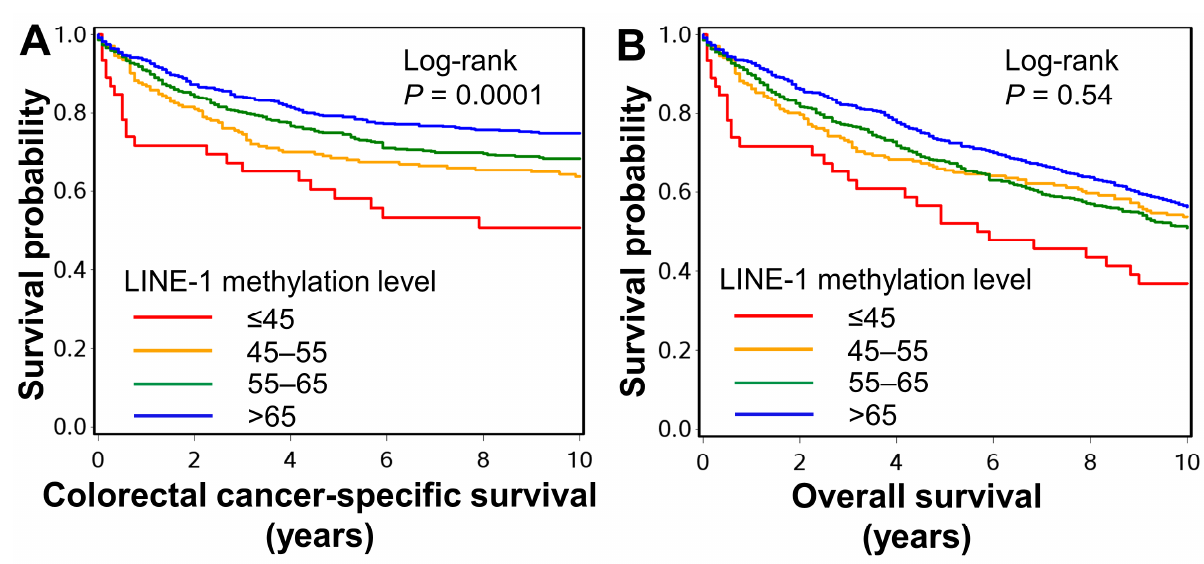
Figure 5. Kaplan–Meier survival curves of colorectal cancer-specific survival ( A ) and overall survival ( B ) according to the LINE-1 methylation level. The p values were calculated using the log-rank test for trend (two-sided). Table 3. Number at risk of death during follow-up of patients according to tumor LINE-1 methyla-